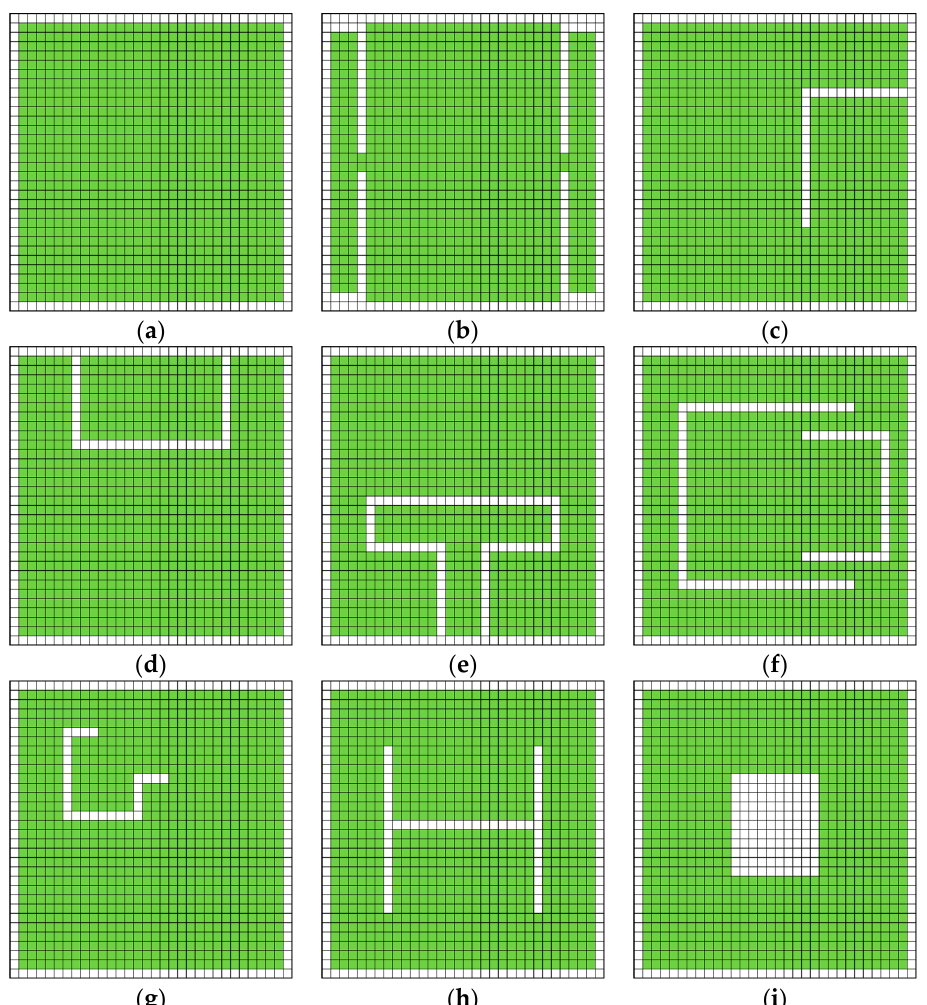
Figure 1. Training geometries of normalized multi-band patches: ( a ) conventional patch, ( b ) extended patch, ( c ) L-slot patch, ( d ) U-slot patch, ( e ) T-slot patch, ( f ) double U-slot patch, ( g ) G-slot patch, ( h ) H-slot patch, and ( i ) square-slot patch. Pixel dimensions: 5 mm × 5 mm. Green: conductive surface; white: uncovered substrate.